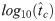
Distributions of log10(t^c) values for 1% frequency alleles (singletons) from representatives of five super-populations.Shown in each panel are distributions for alleles found only in that population at 1% (Private), alleles that are at 1% in that population, but also shared with one or more other populations (Shared), and the sum of Private and Shared. A. the Peruvian population(PEL) from the admixed American super-population. B. the Turin population (TSI) from Europe. C. the Yoruban population (YRI) from Africa. D. the Bengali population (BEB) from South Asia. E. the Bejing Han Chinese population (CHB) from East Asia.